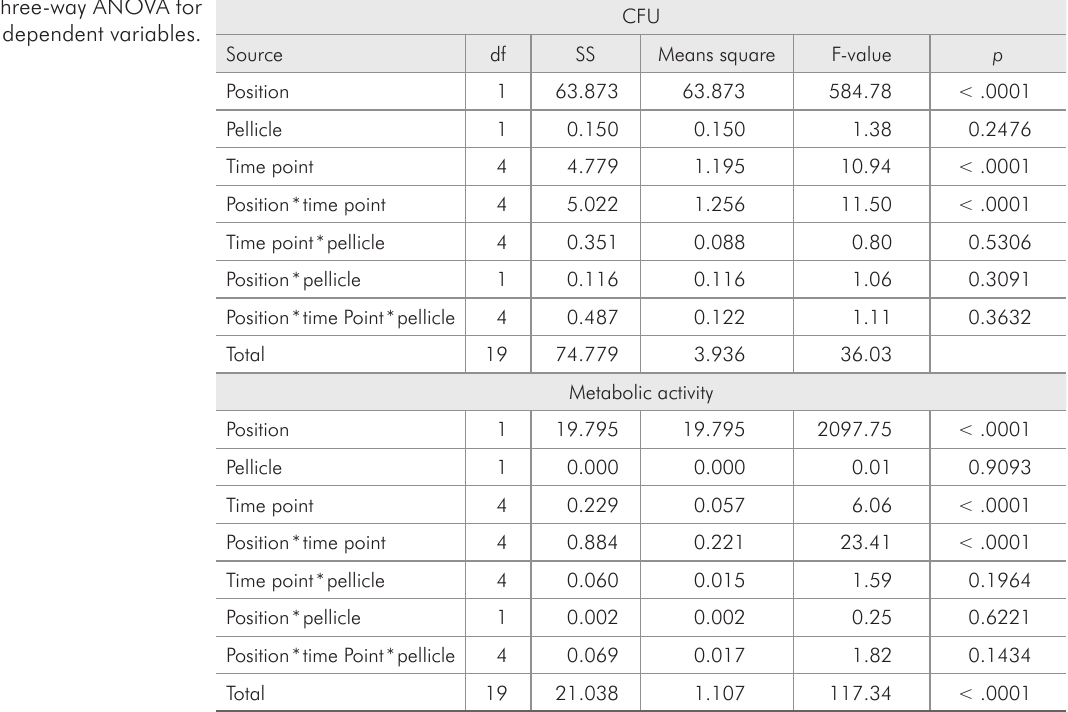
Table 1 - Three-way ANOVA for dependent